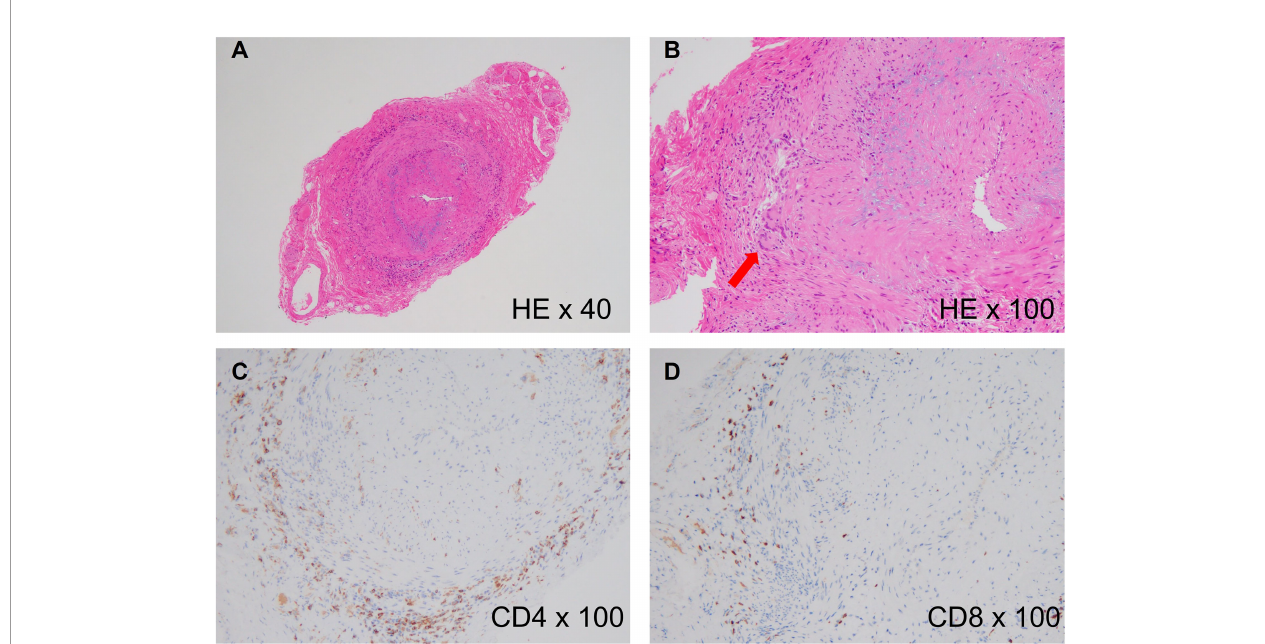
FIGURE 1 | Histology of giant cell arteritis. (A) Histological fi ndings of a temporal artery biopsy from an 82-year-old woman with giant cell arteritis (hematoxylin and eosin staining, x40), showing intense cellular in fi ltration in the adventitia and luminal narrowing due to intimal hyperplasia. (B) High-power image of the biopsy (hematoxylin and eosin staining, x100). The red arrow indicates multinucleated giant cells. (C) CD4 staining of the biopsy (anti-CD4 staining, x100), showing accumulation of CD4 + T cells in the adventitia. (D) CD8 staining of the biopsy (Anti-CD8 staining, x100), showing slight accumulation of CD8 + T cells in the